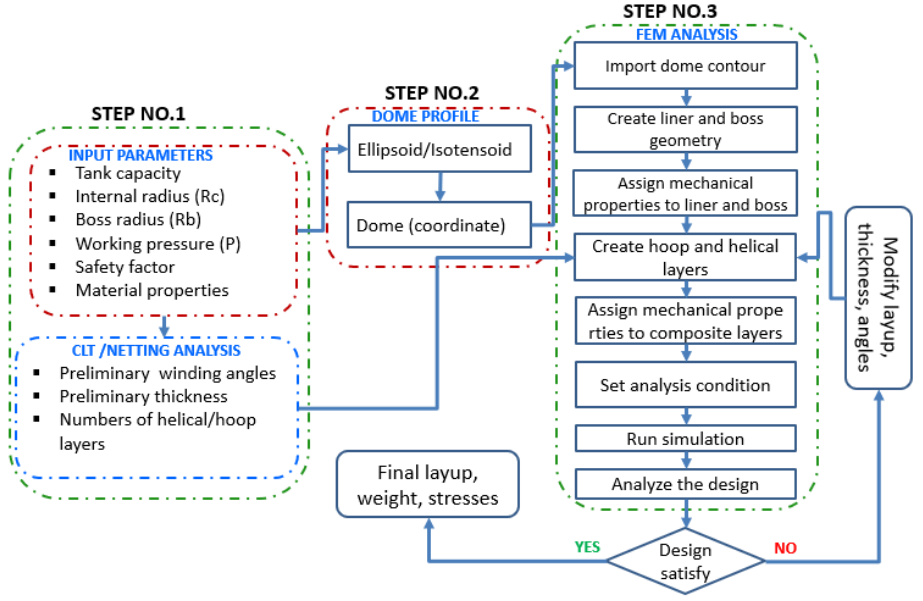
Figure 8. Flowchart of design and analysis of composite hydrogen tank.